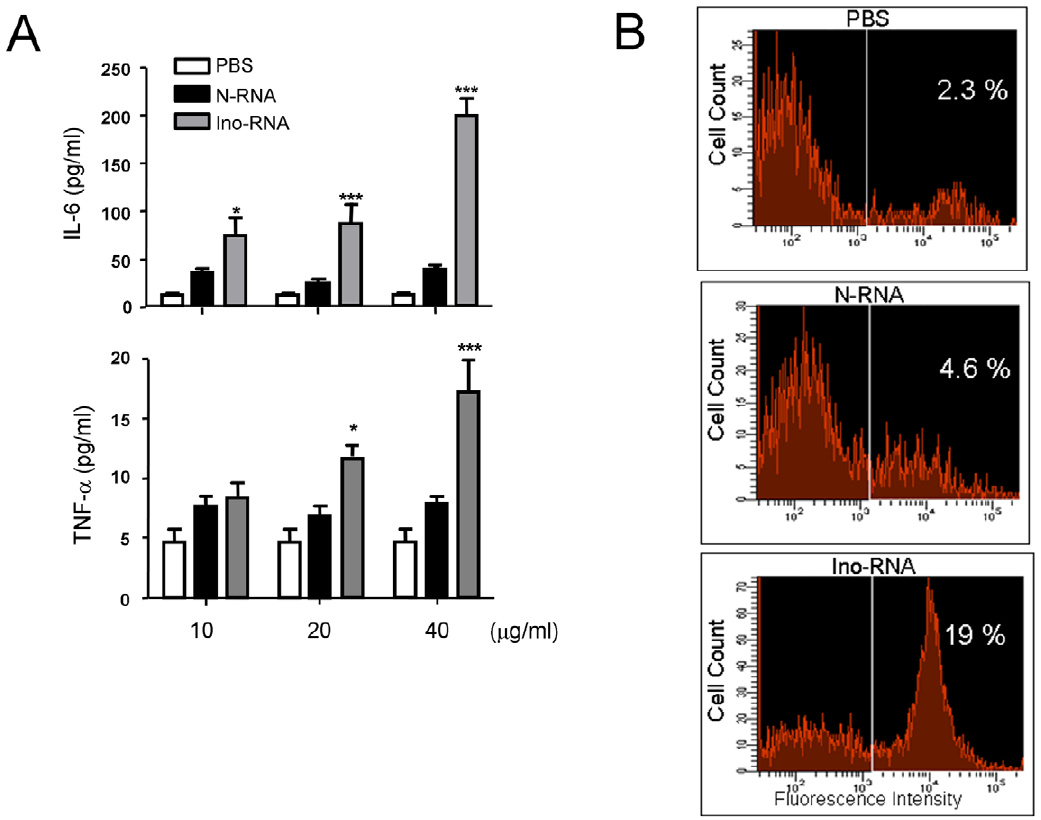
Figure 4. Ino-RNA induces inflammatory responses in C57BL/6 mice. Mice were intratracheally instilled with PBS, N-RNA or 10% Ino-RNA, and BAL fluid was harvested after 24 hr. Panel A , cytokine protein levels were determined in BAL fluid by ELISA (n=3, 6 SEM, *p , 0.05, *** p , 0.001). X-axis presents different RNA concentration. Panel B , flow cytometry analysis of neutrophil recruitment in BAL.